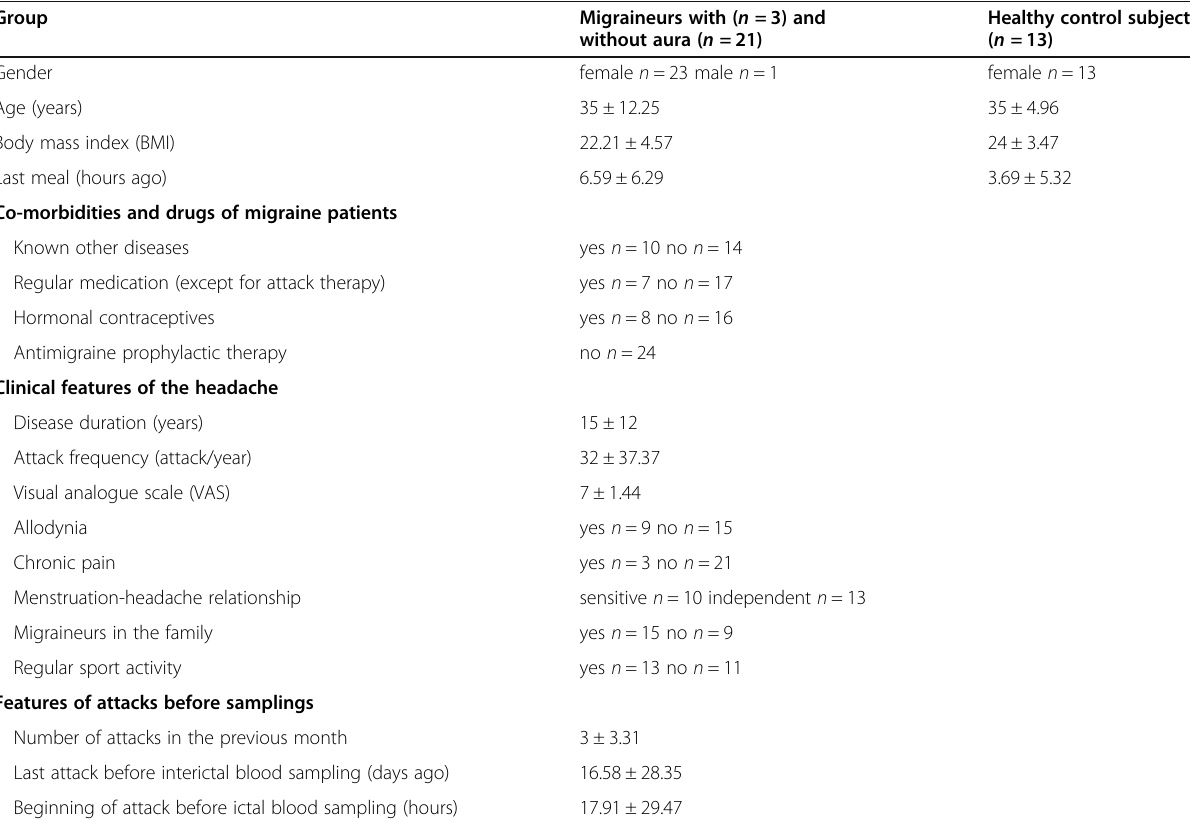
Table 1 Demographic and clinical characteristics of study participants. Mean ± SD values are represented in the table